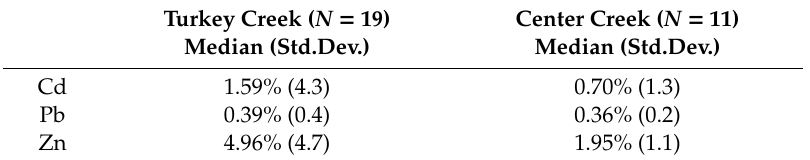
Table 2. Potentially bioavailable fraction (in %) of Center Creek and Turkey Creek sediment